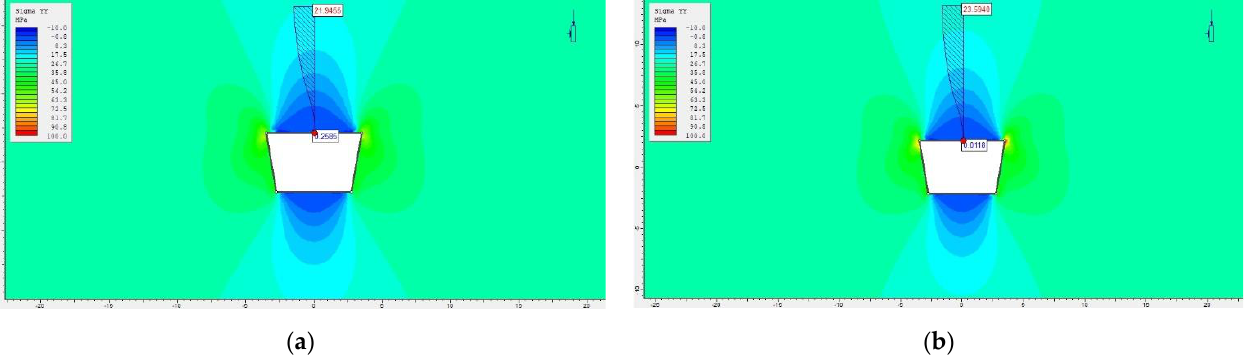
Figure 9. Stress measurement location used to create a graph presenting the distribution of stress acting on the excavation roof in cross-section through: ( a ) ramps; ( b ) entries.